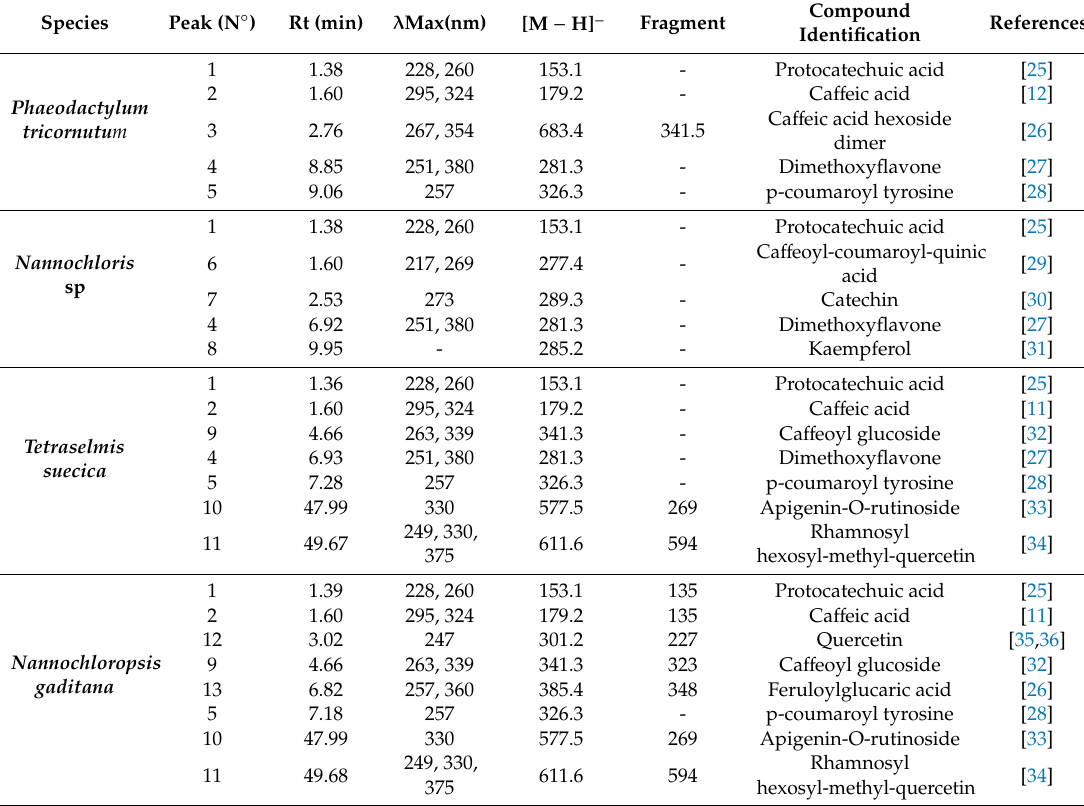
Table 3. UV − vis, retention time, and mass spectrometry characteristics of the polyphenolic compounds tentatively identified in the four microalgae species.